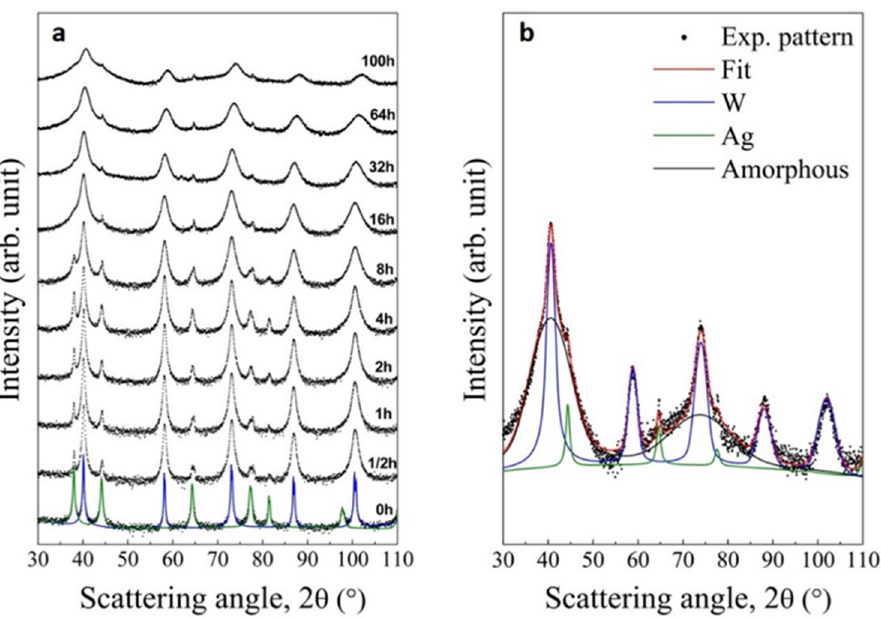
Figure 2. XRD patterns of ( a ) W 85 Ag 15 powder mixtures at increasing BM times and ( b ) powders processed for 100 h. The presence of different phases is highlight by the best-fitted Rietveld profiles also shown in both figures.